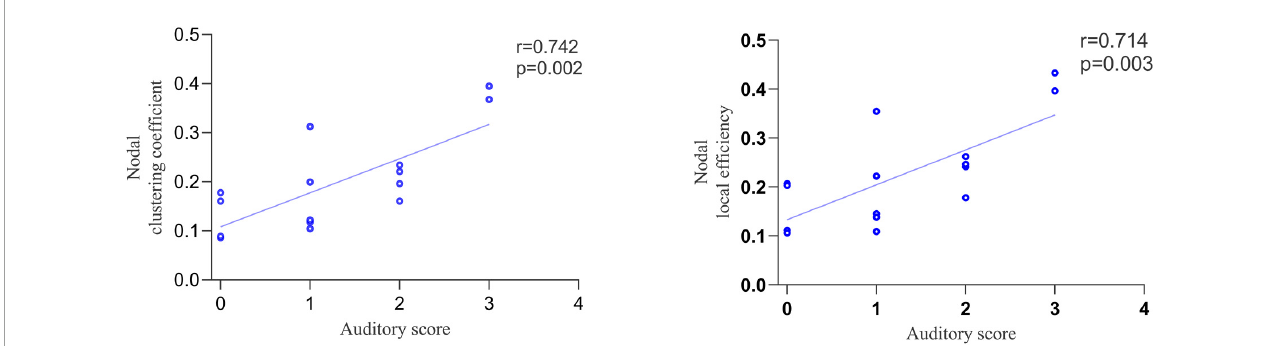
FIGURE5 The correlation between nodal topological properties in right dorsolateral prefrontal cortex (DLPFC) and auditory subscale